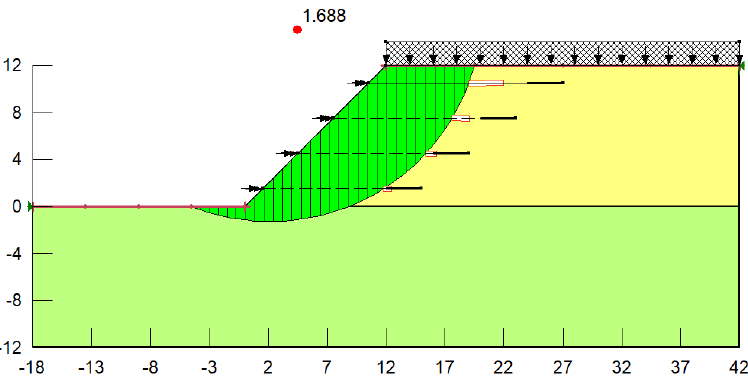
Figure 25. Example 2 calculation results of the stability of Geo.